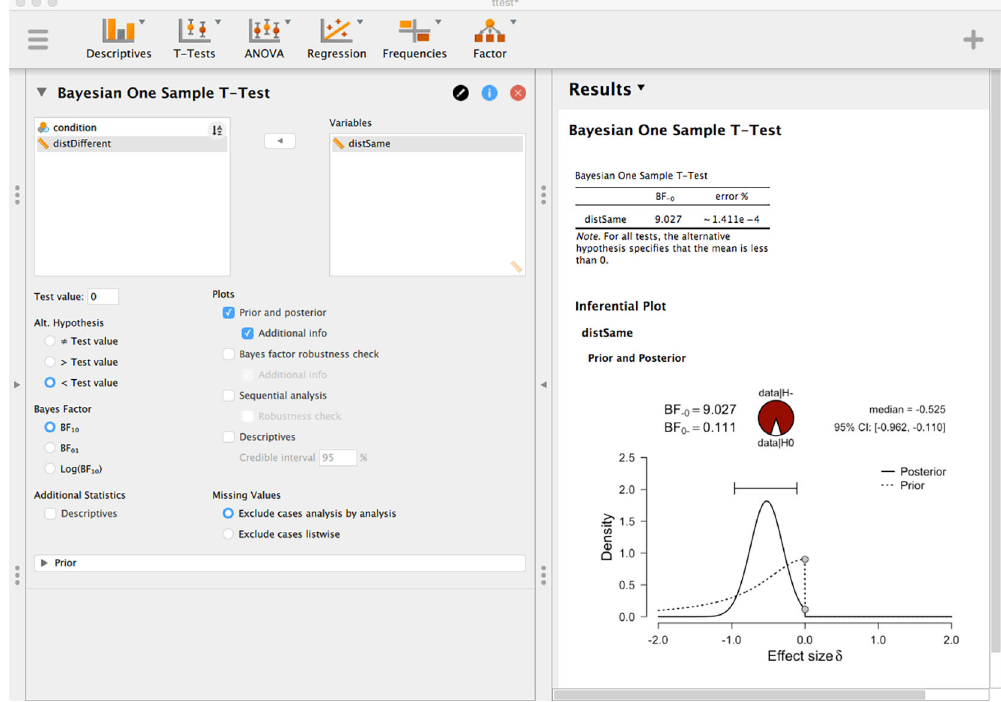
Figure 3. JASP screenshot showing the Bayesian one-sample t -test for